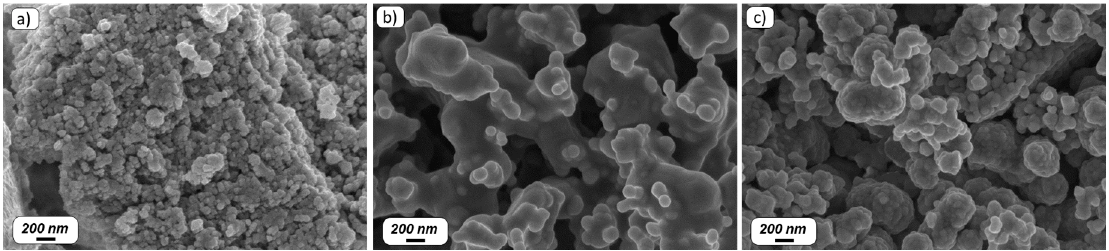
Figure 1. FE-SEM micrographs of Er 2 O 3 -doped TiO 2 ( a ), ZnO ( b ), and ZrO 2 ( c ) particles.